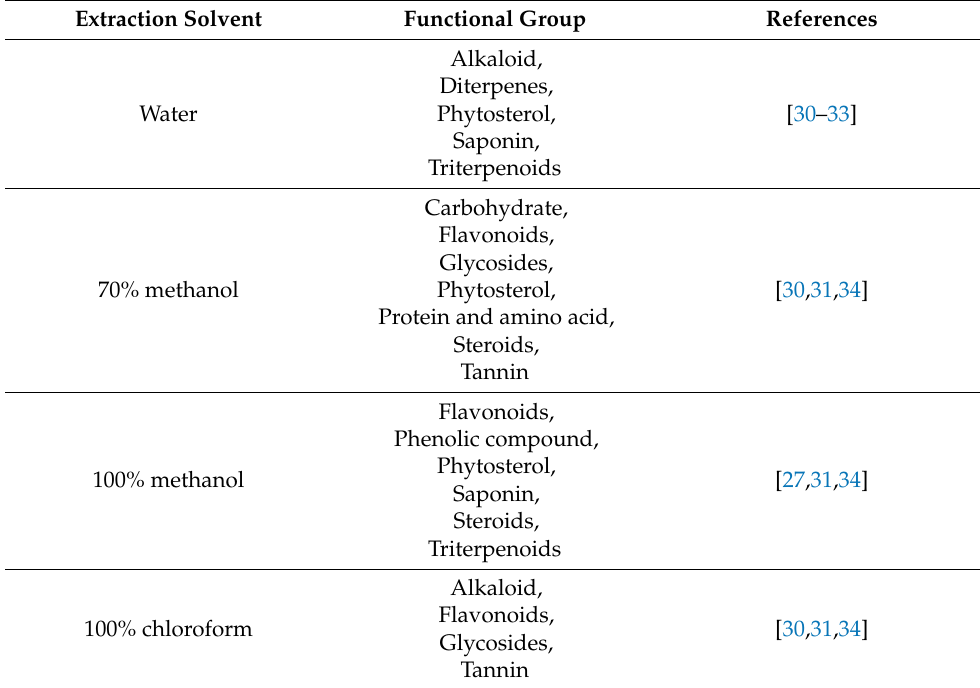
Table 4. The phytochemical functional group obtained from the screening of C. nutans leaves.